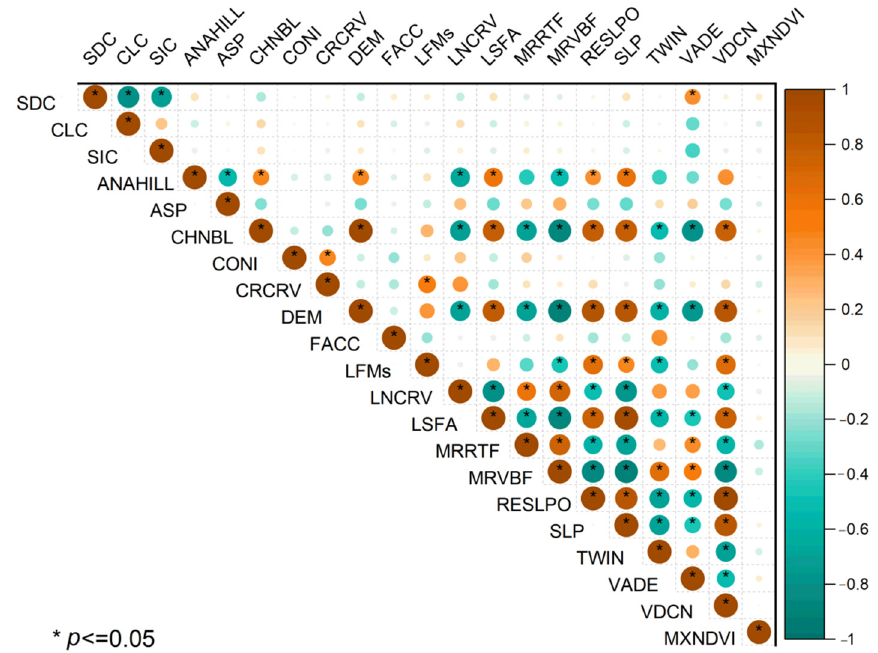
Figure 6. Correlogram overview of all the covariates used to develop the ANN prediction model.SDC: sand particle content; CLC: clay particle content; SIC: silt particle content; ANAHILL: analytical hill-shading; ASP: aspect; CHNBL: channel network base level; CONI: convergence index; CRCRV: cross-sectional curvature; DEM: digital elevation model; FACC: flow accumulation; LFMs: landforms; LNCRV: longitudinal curvature; LSFA: LS Factor; MRRTF: multiresolution index of the ridgetop’s flatness; MRVBF: multiresolution index of the valley-bottom’s flatness; RESLPO: relative slope position; SLP: slope; TWIN: topographic wetness index; VADE: valley depth; VDCN: vertical distance to channel network; MXNDVI: maximum NDVI (normalized difference vegetation index).